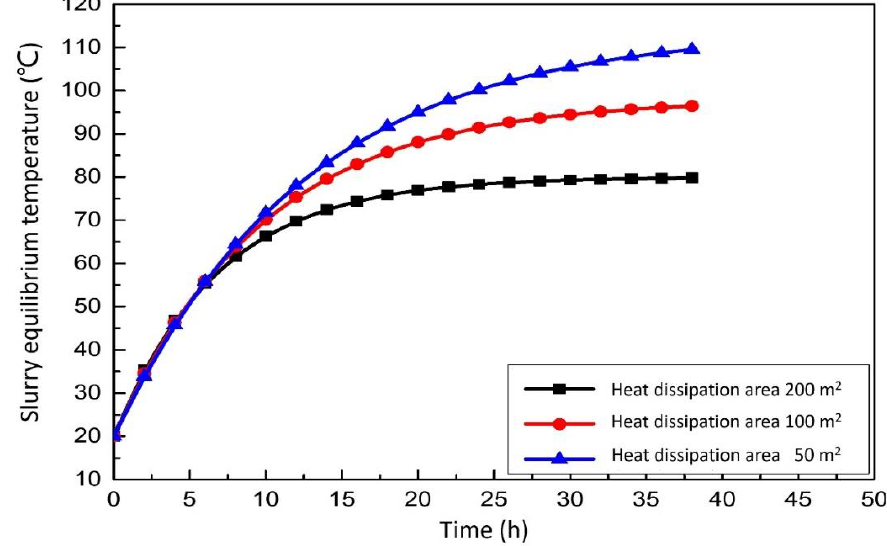
Figure 8. Effect of heat dissipation area on the slurry equilibrium temperature.